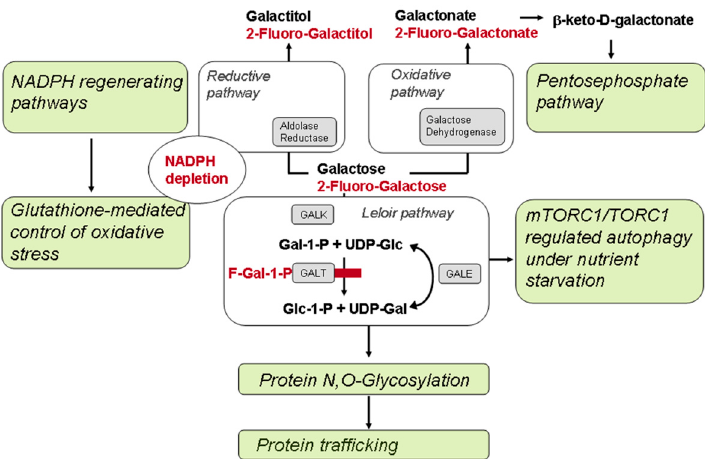
Figure 9. Affected pathways in epithelial MIG cell model (HEK293) of classic galactosemia according to differential proteomics. Galactose can enter the Leloir pathway with formation of Gal-1-P, but is converted at reduced rates to the UDP-Gal due to a competitive inhibition by fluorinated galactose-1-phosphate. Pathways are affected that are related to protein folding, quality control, glycosylation, and targeting to the plasma membrane (contrasting with unaltered N-glycosylation of inducible netrin-1, see above). On the other hand, fluorinated galactose apparently contributes to a depletion of the nicotinamid adenine diphosphate hydrogen (NADPH) pool by aldolase reductase inducing an up-regulation of enzymes involved in the regeneration of NADPH. There is also an impairment of the energy metabolism that could be related to phosphate entrapment by Gal-1-P and F-Gal-1-P. F- Gal-1-P in the figure corresponds to 2-fluoro-2-deoxy-galactose-1-phosphate.